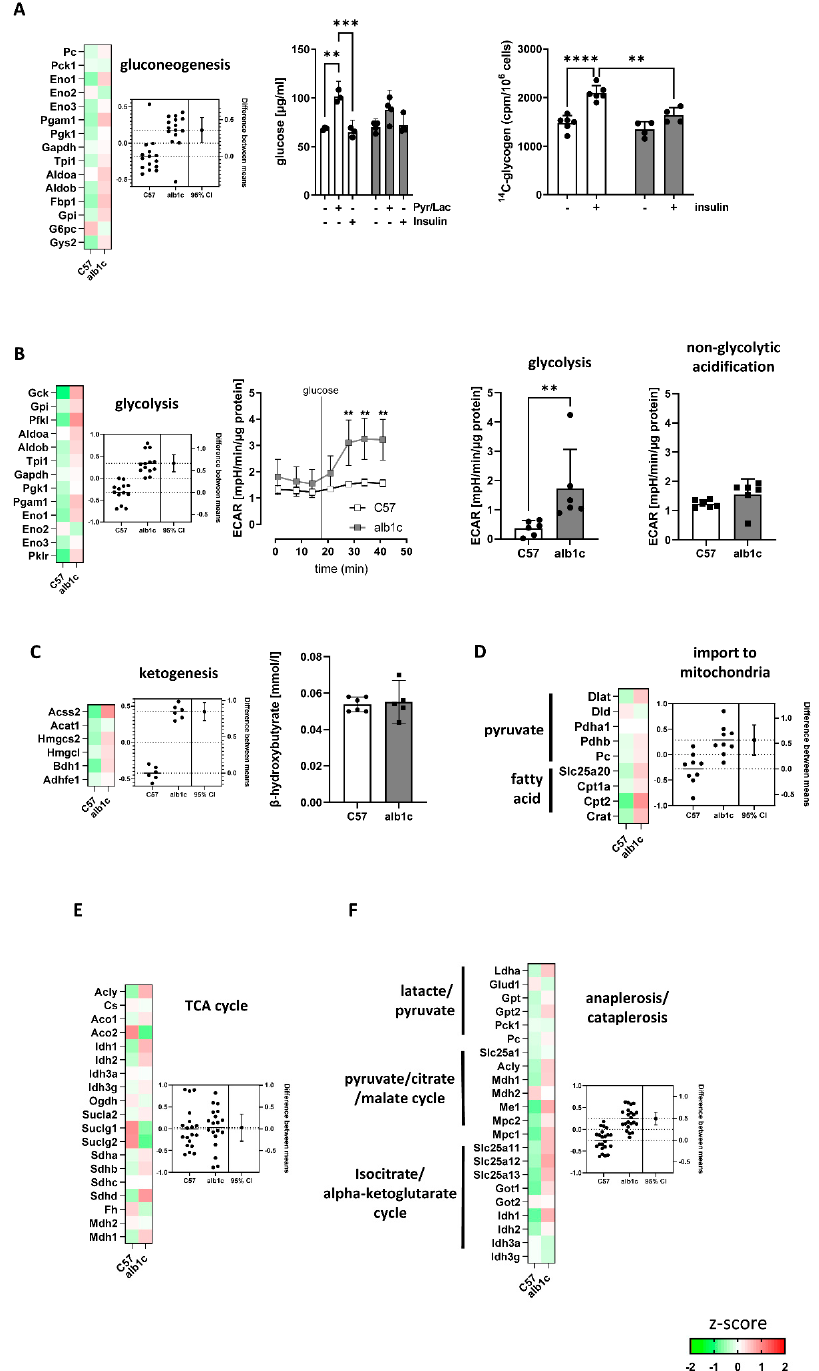
Figure 7. Changes in biosynthesis processes in early-stage MAFLD. ( A – F ) Heat maps resulting from z-score analyses and estimation plots for each pathway are included: ( A ) gluconeogenesis and glycogen synthesis, ( B ) glycolysis, ( C ) ketogenesis, ( D ) import to mitochondria, ( E ) TCA cycle, and ( F ) anaplerosis/cataplerosis. ( A – F ) Functional analysis of metabolic activities was investigated in primary hepatocyte cultures isolated from alb-SREBP-1c vs. C57Bl6 livers. ( C ) β -OH butyrate was analyzed in liver tissue. Estimation plots show the differences between means of alb-SREBP-1c vs. C57Bl6 ( ± 95% CI) (mean z-score: left axis, effect size: right axis). Functional analysis show data expressed as means ( ± 95% CI, n = 3–6 per group, depending on the assay). Statistics: Mann–Whitney test or two-way ANOVA with Tukey’s multiple comparisons, ** p < 0.01, *** p < 0.001, **** p < 0.0001. C57: C57Bl6, alb1c: alb-SREBP-1c, Pyr/Lac: pyruvate,